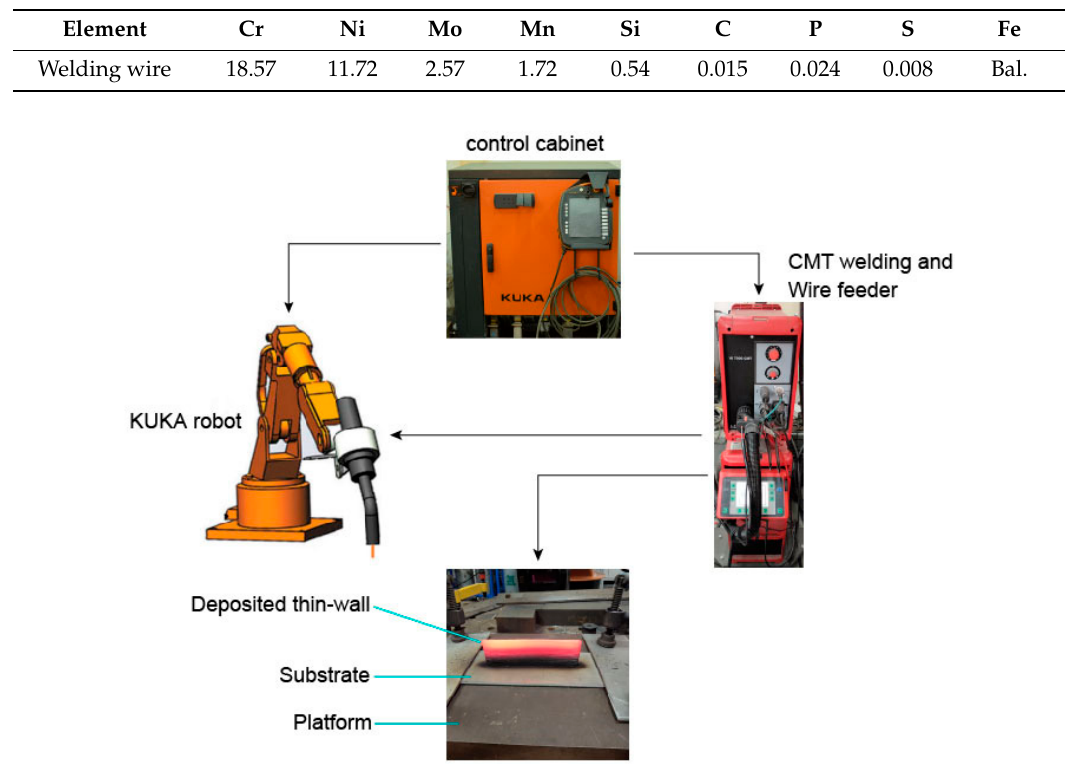
Table 1. Chemical properties of ER316L wire (mass fraction/%).